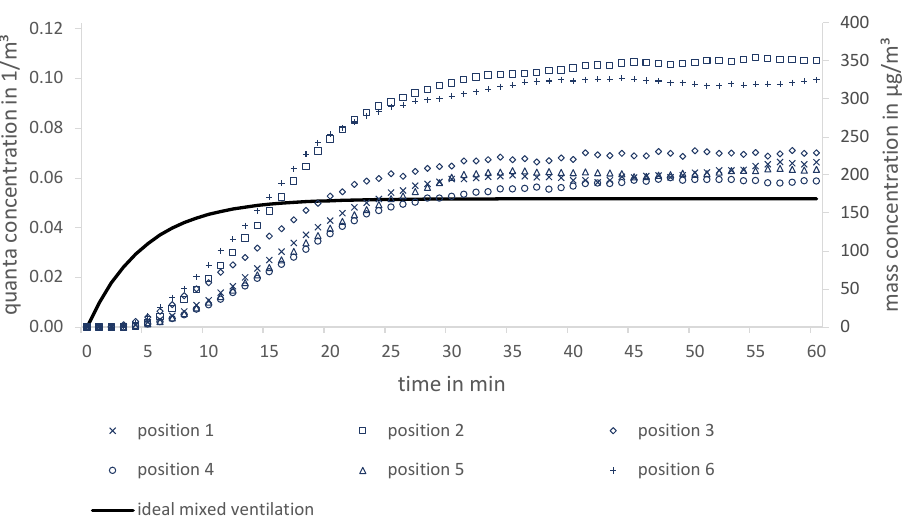
Figure 5. Theoretical (ideal mixed air) and measured quanta concentration (left axis) and their related mass concentration (right axis) of six positions in a two-person